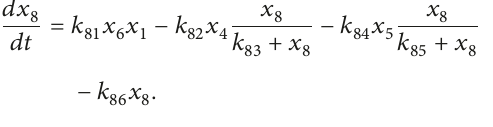
Table 1: Parameters for the